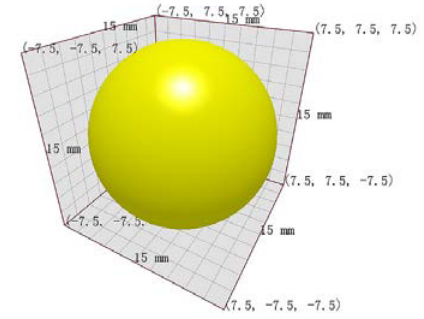
Fig. 3. Particle shape and size.